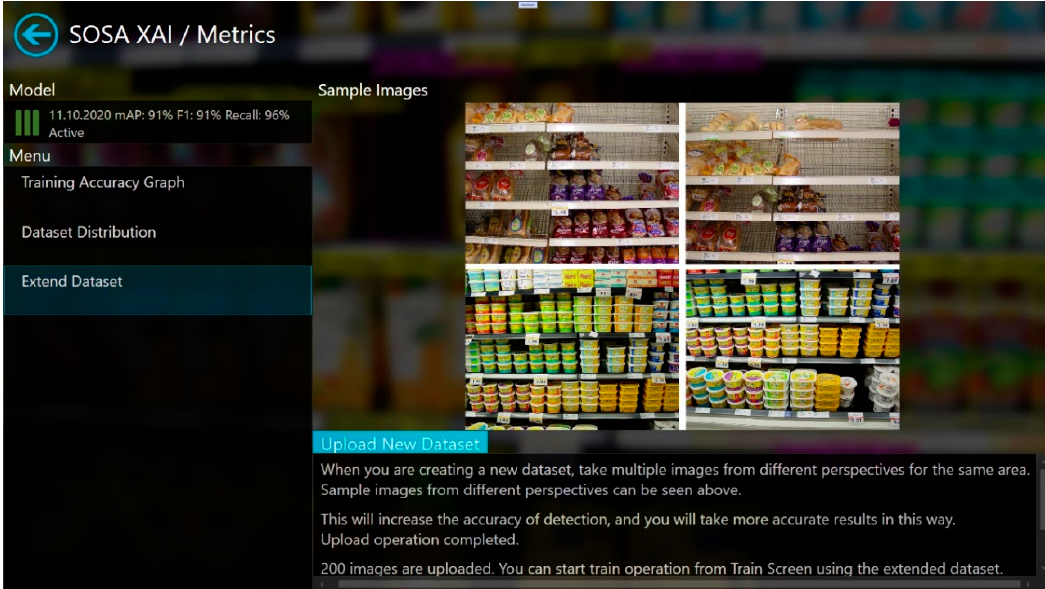
Figure 6. Metrics screen of SOSA XAI.